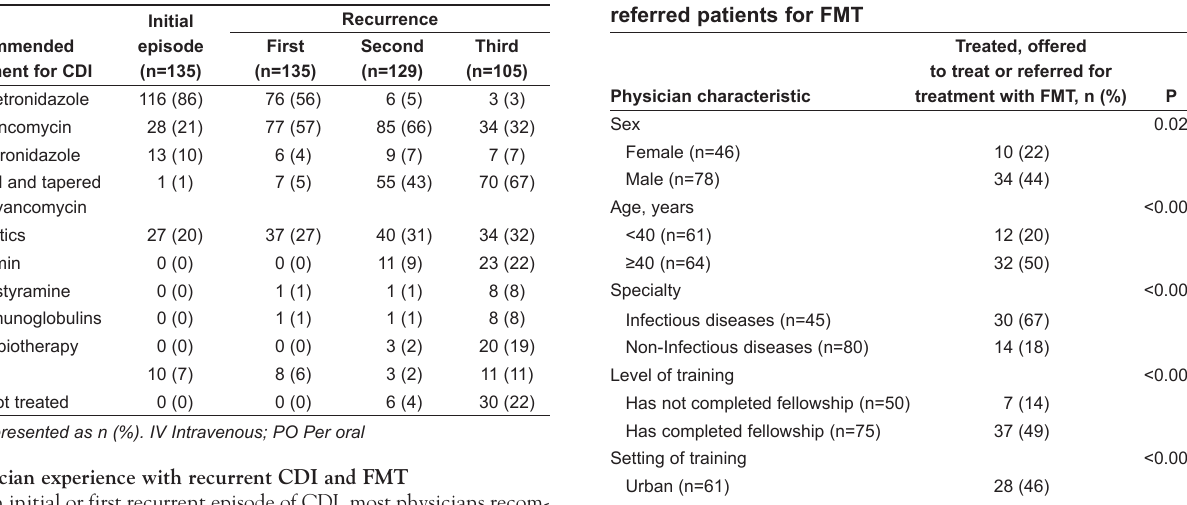
TAble 3 Physician characteristics associated with having treated